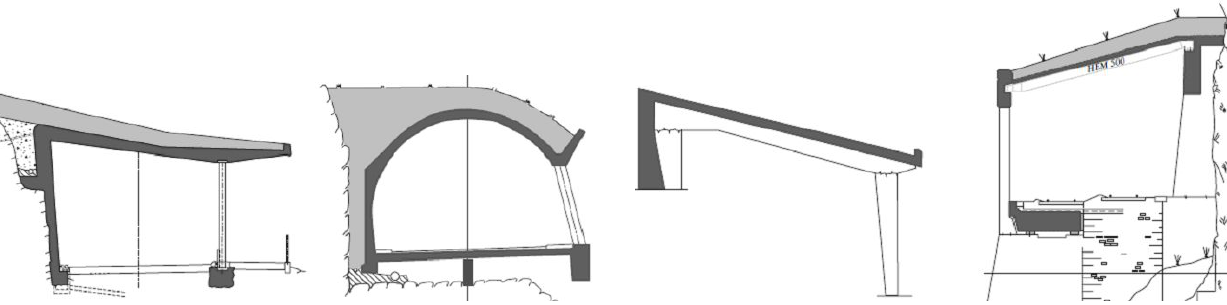
Fig. 11. Different types of shed structures (fltr): reinforced-concrete slab, shell type, in situ reinforced concrete, and steel-concrete-composite type (from Vogel et al., 2009).